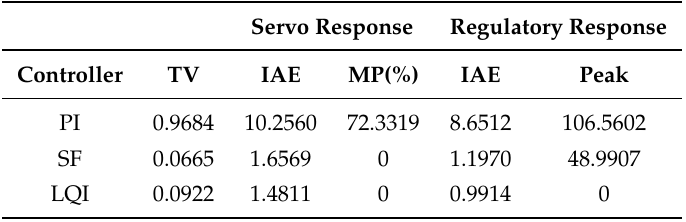
Figure 10. Simulation results for a load disturbance of 4 A under a process noise with zero means and covariance matrices of 100. Table 4. Performance indices of the perturbed closed-loop responses ( D = 0.45 and R o =